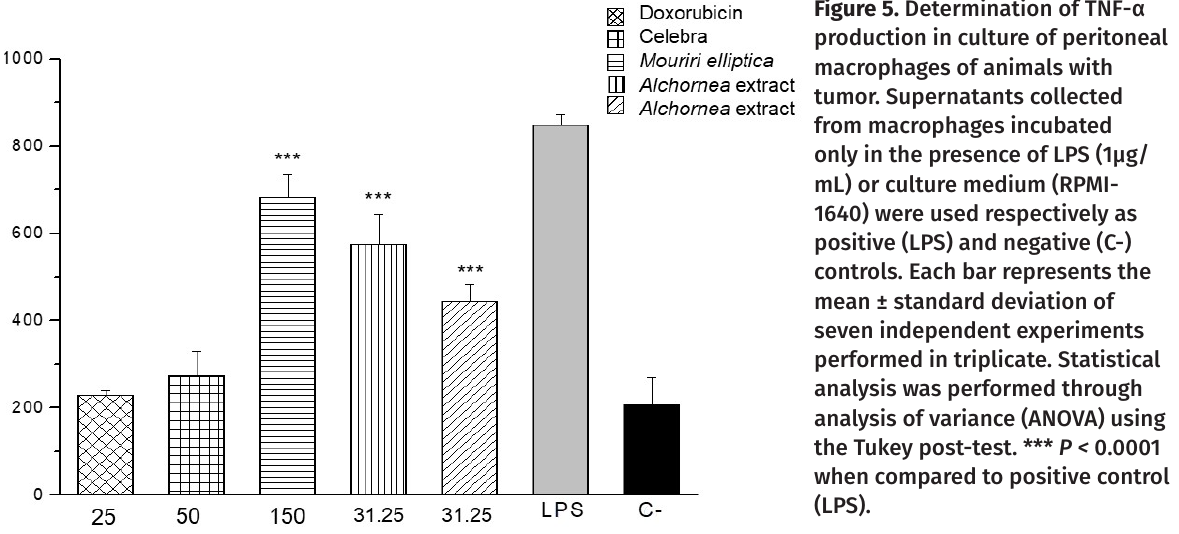
Figure 5. Determination of TNF-α production in culture of peritoneal macrophages of animals with tumor. Supernatants